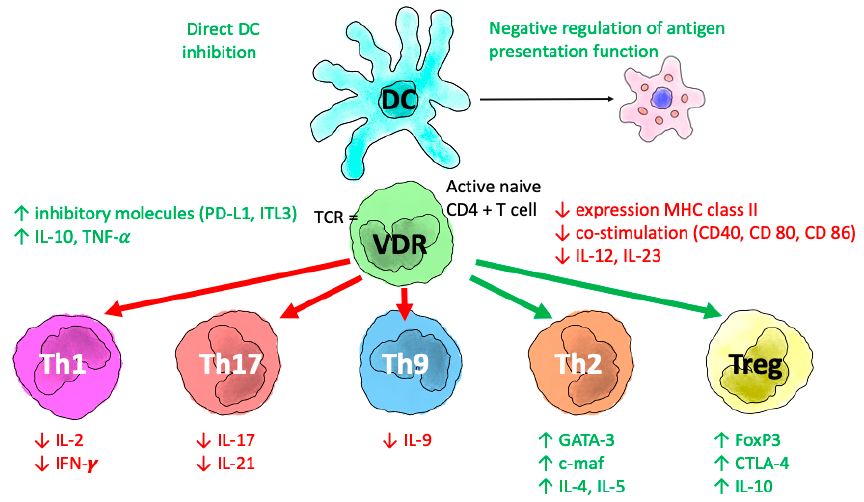
Figure 4. Immunomodulatory actions of calcitriol (1,25 dihydroxy vitamin D3). 1-25OH-D3 exerts effects through the VDR on T lymphocytes and antigen-presenting cells (APCs, in this case the dendritic cell, DC). The effect is upregulation of direct inhibition of APCs and downregulation of antigen presentation. On T lymphocytes, the direct effect consists of induction of T helper-2 lymphocytes (Th2) and regulatory T lymphocytes (Tregs; represented in green text), together with downregulation of T helper-1 (Th1), T helper-17 (Th17), and T helper-9 (Th9) lymphocytes (represented in red text). Abbreviations: IL: interleukin; IFN- γ : interferon- γ ; TNF- α : tumor necrosis factor- α ; ILT-3: immunoglobulin-3-like transcription; GATA-3: GATA-3 binding protein; FoxP3: forkhead box P3, CTLA-4: protein 4 associated with cytotoxic T